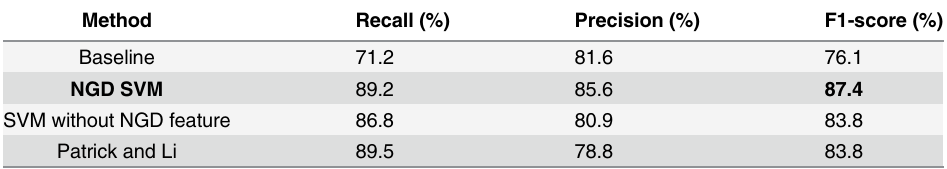
Table 5. Detailed results of auxiliary description matching on